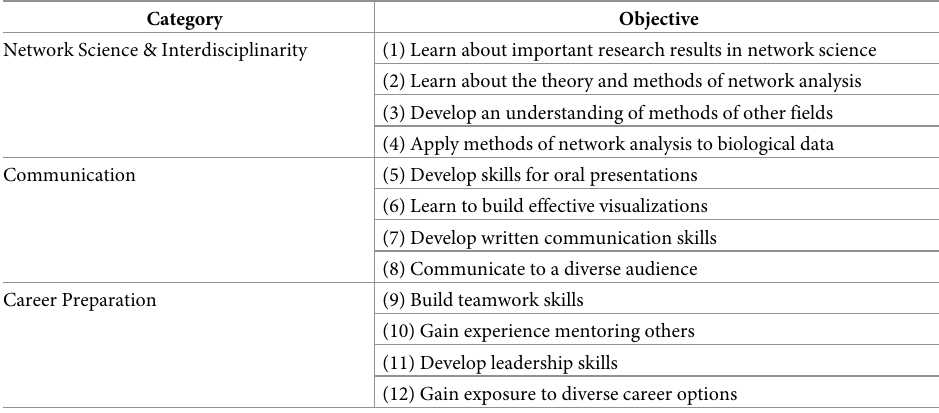
Table 1. COMBINE program